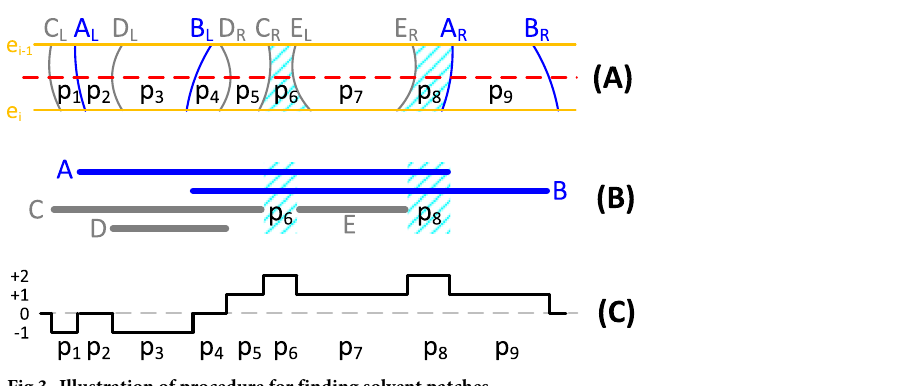
Fig 3. Illustration of procedure for finding solvent